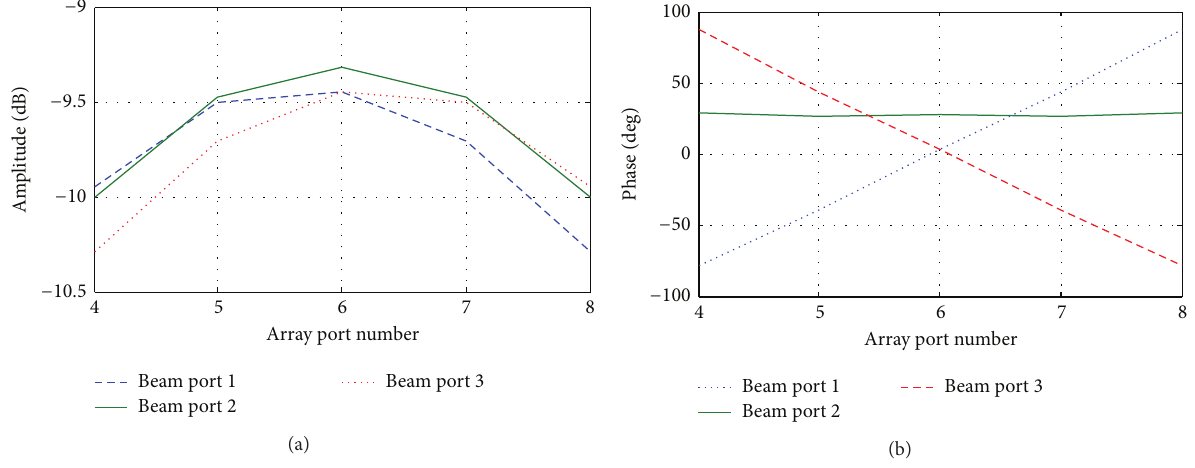
Figure 4: (a) Beam to array coupling amplitude, (b) beam to array coupling phase.